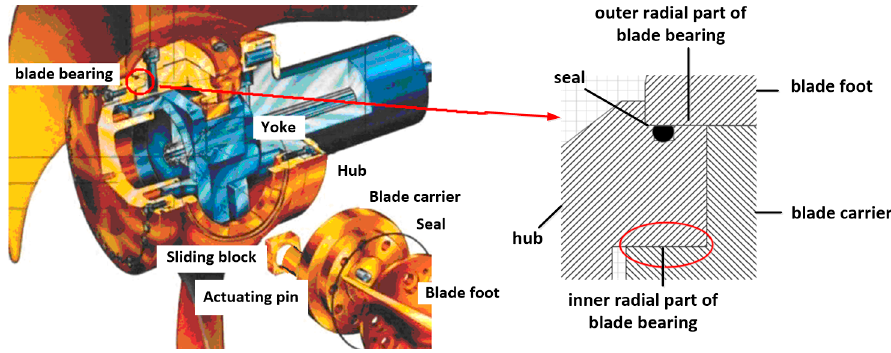
Figure 1. Assembly of a controllable pitch propeller (CPP) [14].